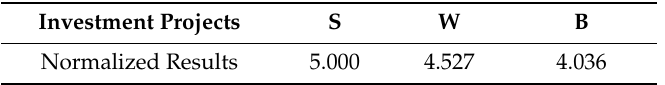
Table 6. Normalized real option valuation (ROV) results for three